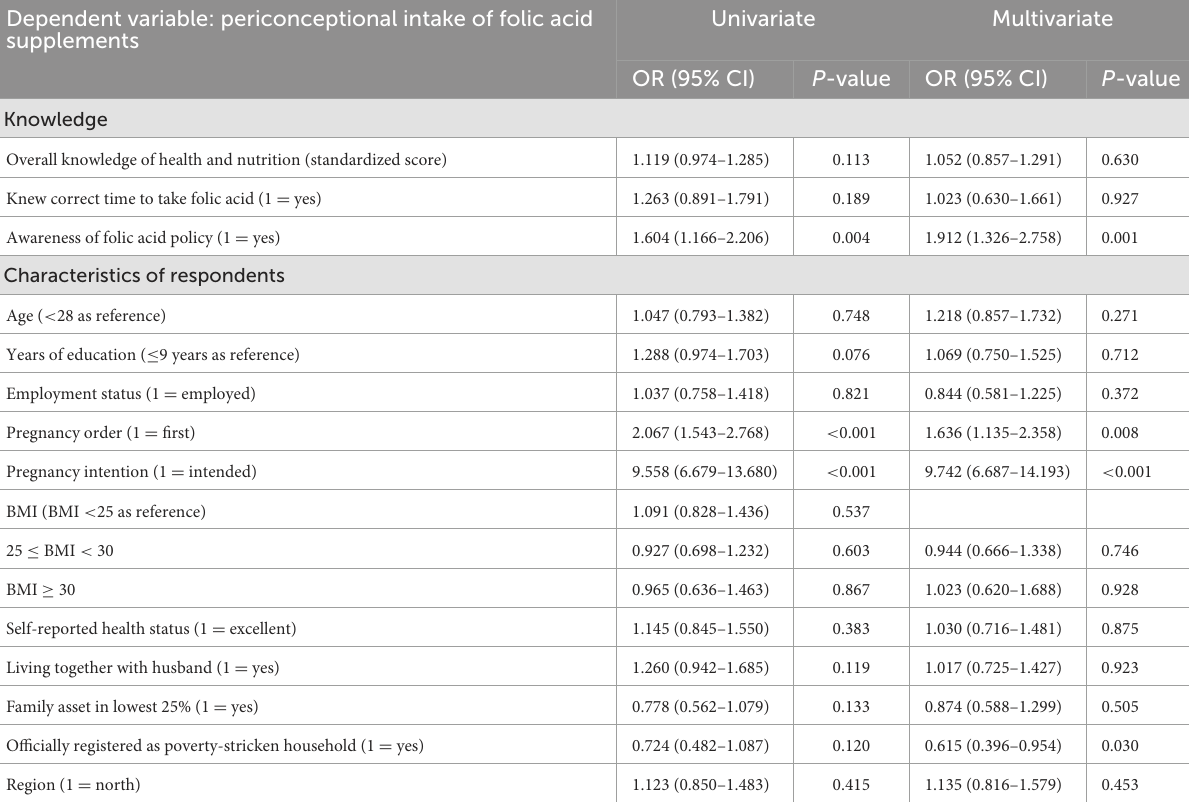
TABLE 4 Results of univariate and multivariate logistic regression analyses of variables related to the periconceptional intake of folic acid supplements. Dependent variable: periconceptional intake of folic acid supplements